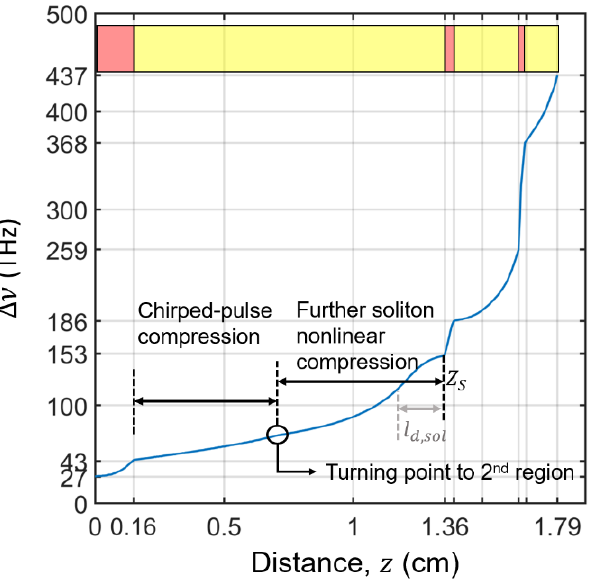
Figure 8. Numerical results using same parameters as for Figure 7. Spectral bandwidth development plotted against propagation distance within the sign-alternating dispersion waveguide. The two regions of spectral generation are shown for the first AD segment. An output bandwidth of 437 THz is obtained. The chip segments are shown at the top (red for ND segments, yellow for AD segments).